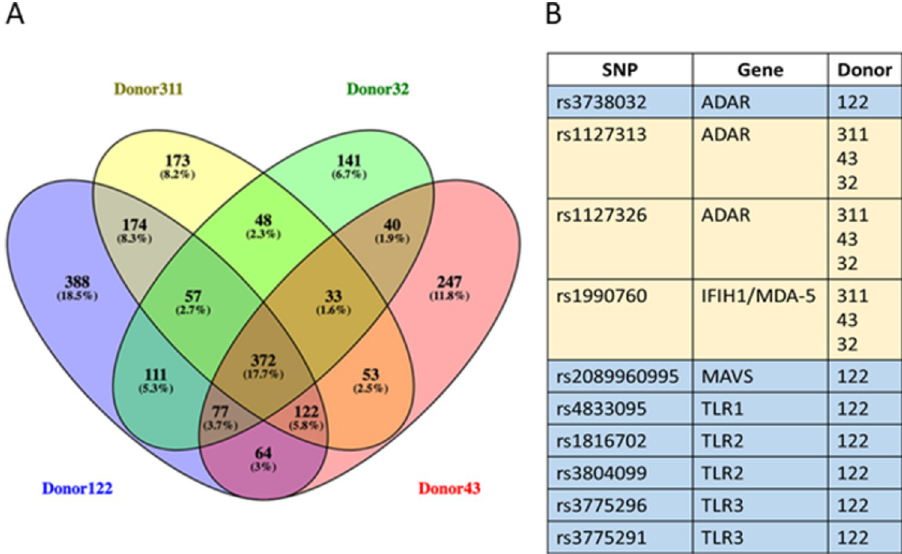
Fig 5. SNP analysis from transcriptomics data. SNPs unique to each donor and common displayed as a Venn diagram (A). SNPs unique to donor 122 (blue) or not present in donor 122 (yellow) were filtered by quality ( > 10), with an existing entry in dbSNP (NIH) and previously published